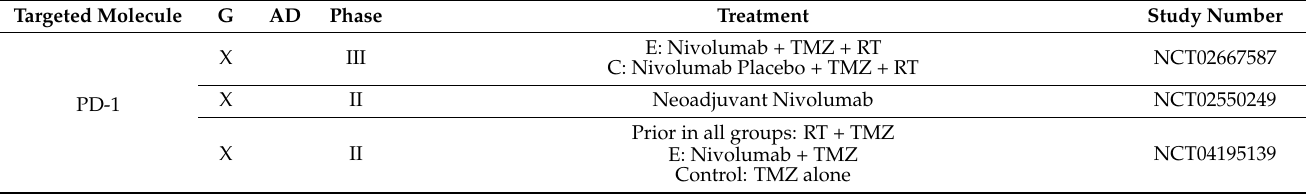
Table 1. Clinical trials of classical and nonclassical immune modulators in autoimmune diseases and glioma. Targeted